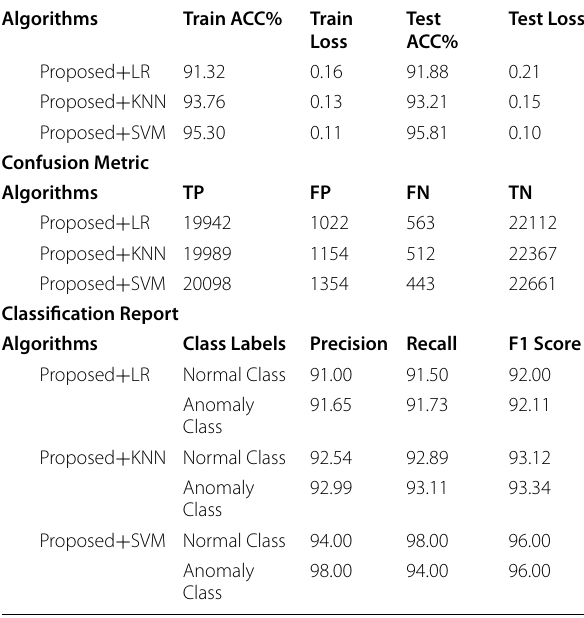
Table 2 Normal and Anomaly classification experimental results